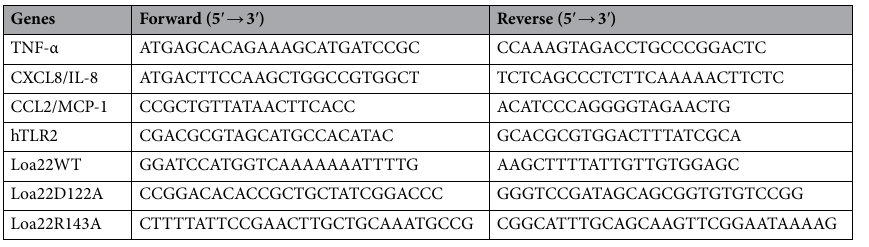
Table 1. Primers used in this